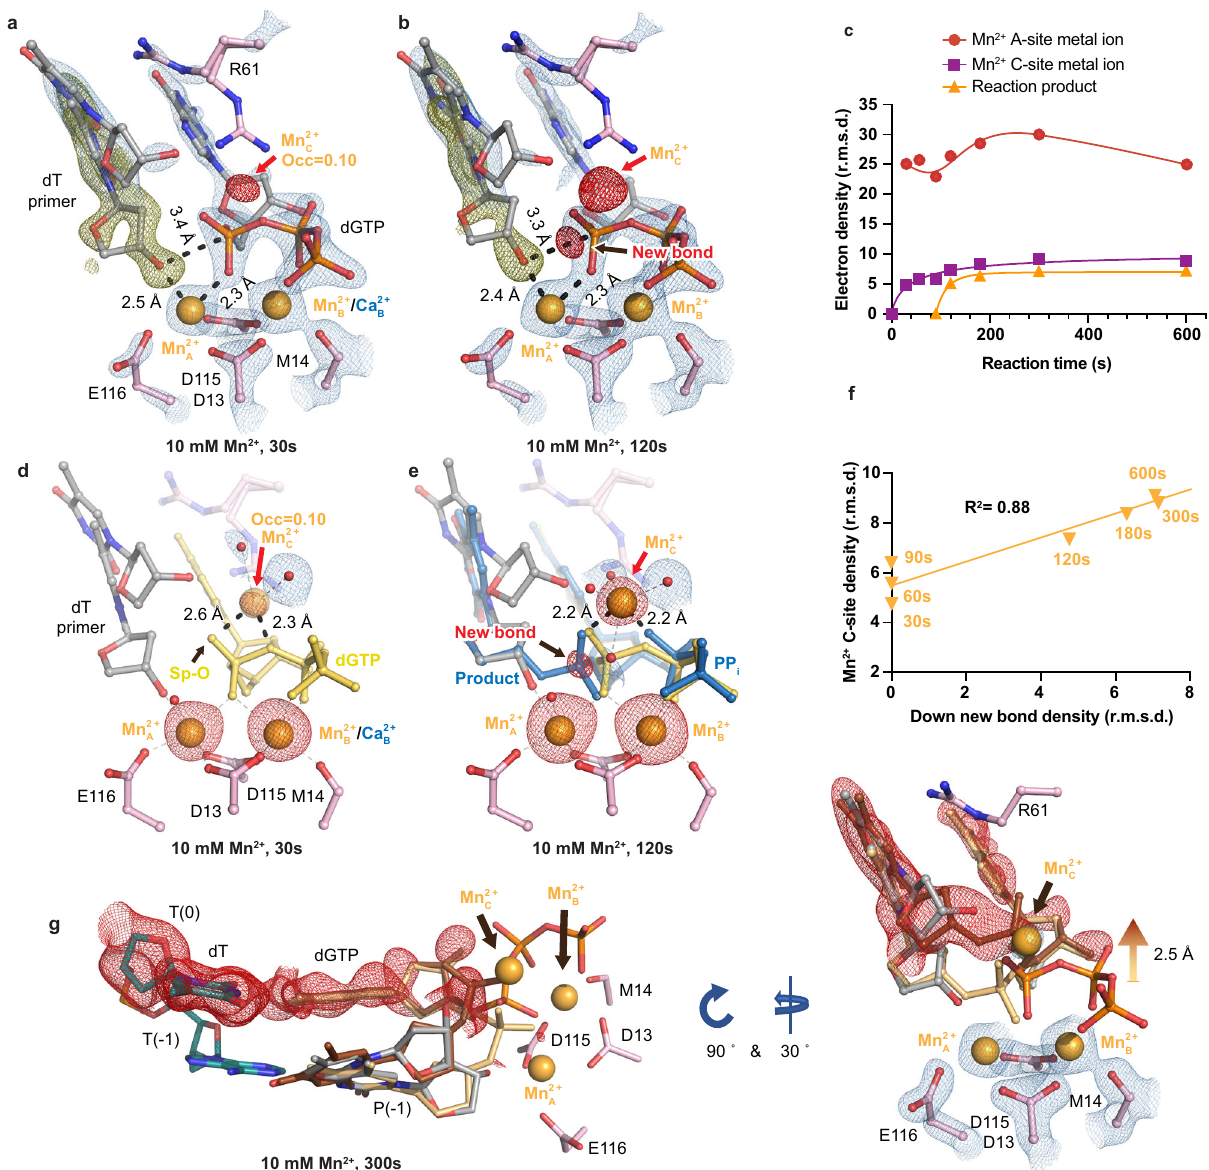
Fig. 3 In crystallo visualization of Pol η misincorporation with Mn 2 + . a , b Structures of Pol η during in crystallo catalysis after 10mM Mn 2 + soaking for 30s ( a ) and 120s ( b ). The 2F o -F c map for the primer up conformation (blue) was contoured at 1.2 σ . The 2F o -F c map for the Me 2 + A , Me 2 + B , dGTP, and catalytic residues (blue) were contoured at 2.5 σ in ( a – c ). The F o -F c omit map for the down conformation of the primer (green) was contoured at 3.3 σ in ( a – c) . The F o -F c omit map for all the Mn 2 + C , and newly formed bond (red) was contoured at 4 σ . c Timescale of Mn 2 + A , Mn 2 + C binding and reaction product in crystallo with Mn 2 + . d , e Observation of the Mn 2 + C after 10mM Mn 2 + soaking for 30s ( d ) and 120s ( e ). f Correlation ( R 2 ) between the newly formed bond and the Mn 2 + C binding. In d , e , the 2F o -F c map for the water molecules that were coordinated by the Mn 2 + C was contoured at 0.7 σ . The F o -F c omit map for the Mn 2 + C , new bond, and Mn 2 + A and Mn 2 + B was contoured at 4 σ . c , f The data points represent singular measurements for r.m.s. density values of electron density. g Alternative product state of Pol η in crystallo with 10mM Mn 2 + at 300s. The 2F o -F c map for the primer up conformation, primer down conformation, Me 2 + A , Me 2 + B , Me 2 + C , and dGTP (blue) was contoured at 2 σ . The F o -F c omit map for the up conformation of the product state (red) was contoured at 3 σ